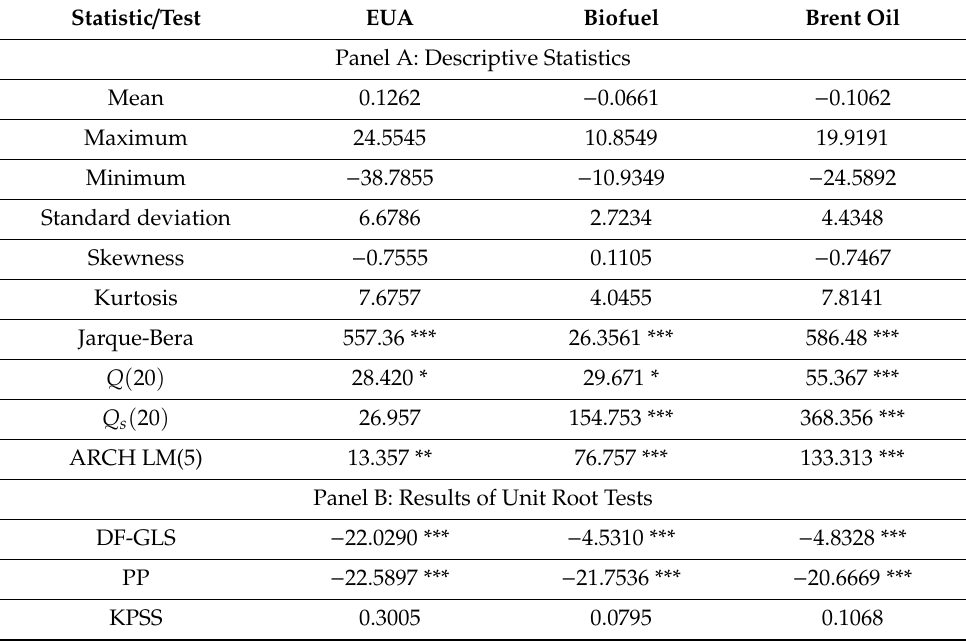
Table 1. Descriptive statistics and unit root test results for the